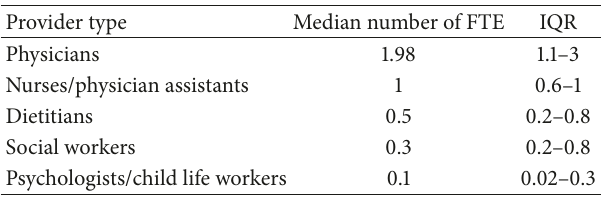
Table 1: Median and interquartile range (IQR) of number of healthcare providers available for the care of children with IBD per pediatric centre in Canada.